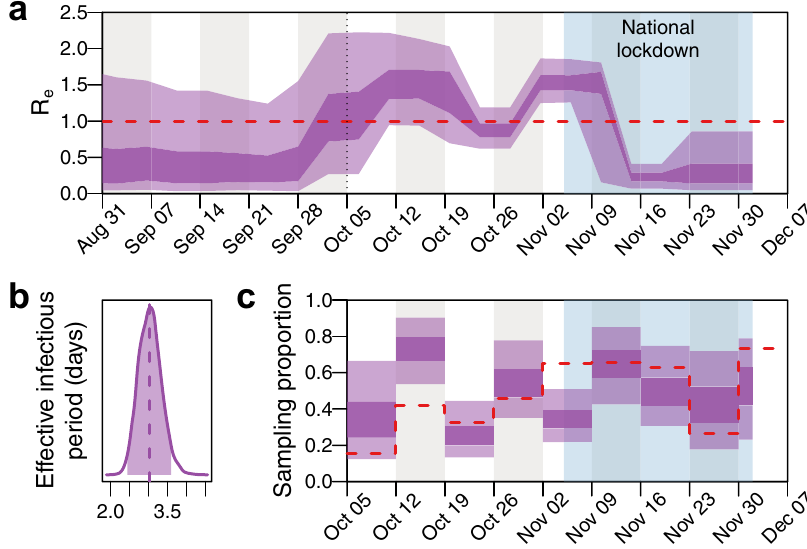
Fig. 5 Effective reproduction number and infectious period of SARS-CoV-2 from a dominant university cluster. A 20-epoch birth-death skyline model shows the effect of local infection control measures and the national lockdown on the effective reproduction number ( R e ), and estimates of the mean effective infectious period as 3.03 (95% HPD = 2.44-3.59) days. a R e posterior estimates (dark shading = 50% HPD; light shading = 95% HPD). The dotted line indicates the start of term and the light blue shaded area the 4-week national lockdown in the UK, which was associated with a large fall in COVID-19 cases in University students. The red dashed line indicates R e = 1. b Effective infectious period posterior estimates (shaded region = 95% HPD; dashed line = median). c Weekly sampling proportion posterior estimates (dark shading = 50% HPD; light shading = 95% HPD). The red dashed line indicates the empirical sampling proportion estimates for each week in term (number of sequenced genomes from all University clusters divided by the number of positive tests among University staff and students). Source data are provided as a Source Data fi